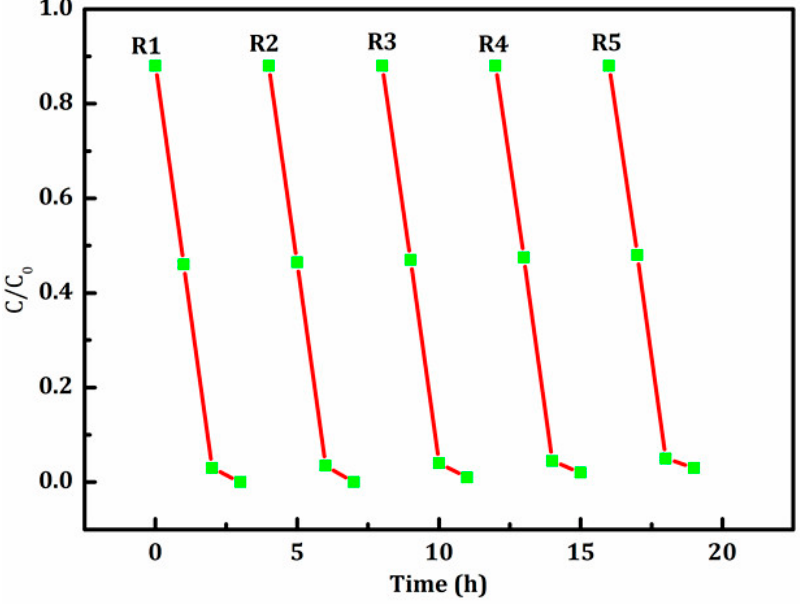
Figure 10. Recycling experiments of degrading RhB with BiVO 4 /Mn 1 − x Zn x Fe 2 O 4 (15 wt %).